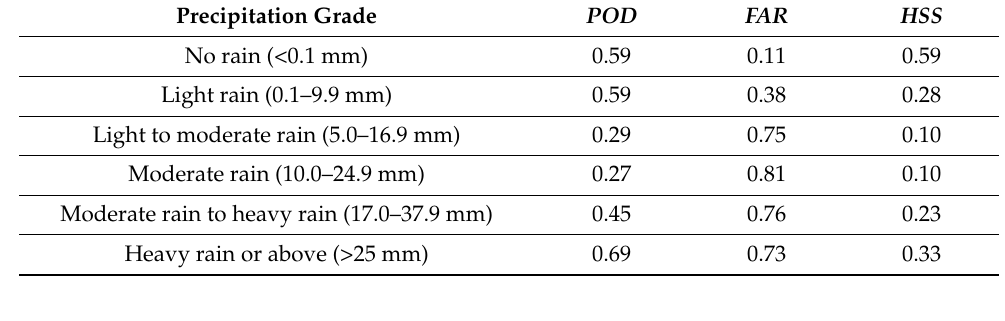
Table 4. Classified statistical indices of PRE during 2013–2017.